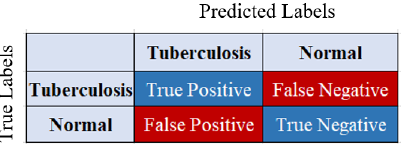
The findings are expressed as a percentage. As a best results in two datasets which are Tuberculosis (TB) Chest X-ray (Accuracy=98.35%, F1-score=98.32%) and Montgomery Chest X-ray (Accuracy=77.81%, F1- score=78.92%). It also produces good performance on two datasets left, including the Shenzhen Chest X- Figure 9. Confusion Matrix ray dataset (Accuracy=67.19%, F1-score=74.86%), and the India Chest X-ray dataset (Accuracy=86.25%,